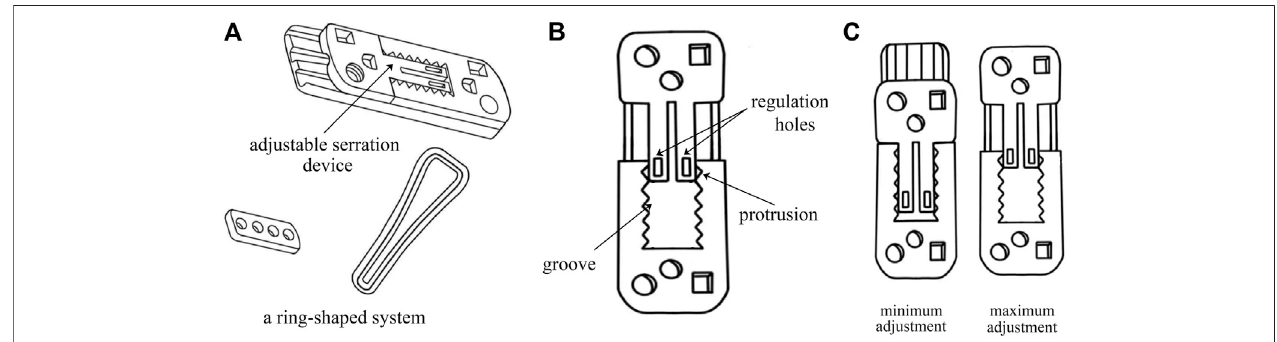
FIGURE 1 | The detail information of the NAE: (A) the EndoButton and the suture formed a ring-shaped system; (B) the frontal view of the adjustable serration device including regulation holes, special grooves, and protrusions; and (C) the minimum and maximum adjustment of the EndoButton.